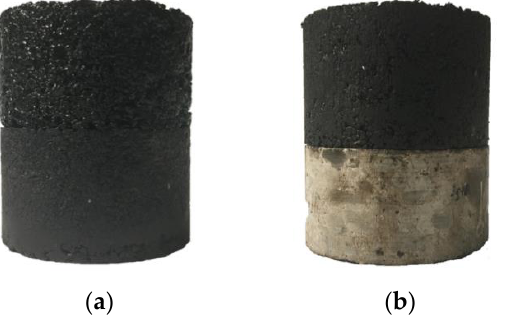
Figure 8. Double-layered specimen: ( a ) double-layered asphalt specimen (system I); ( b ) double-layered composite specimen (system II).